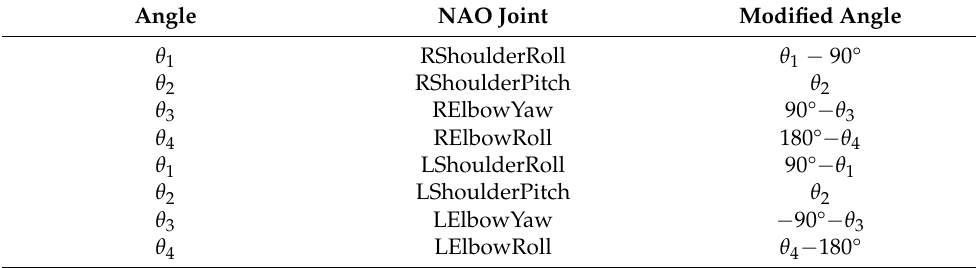
Table 2. NAO joint